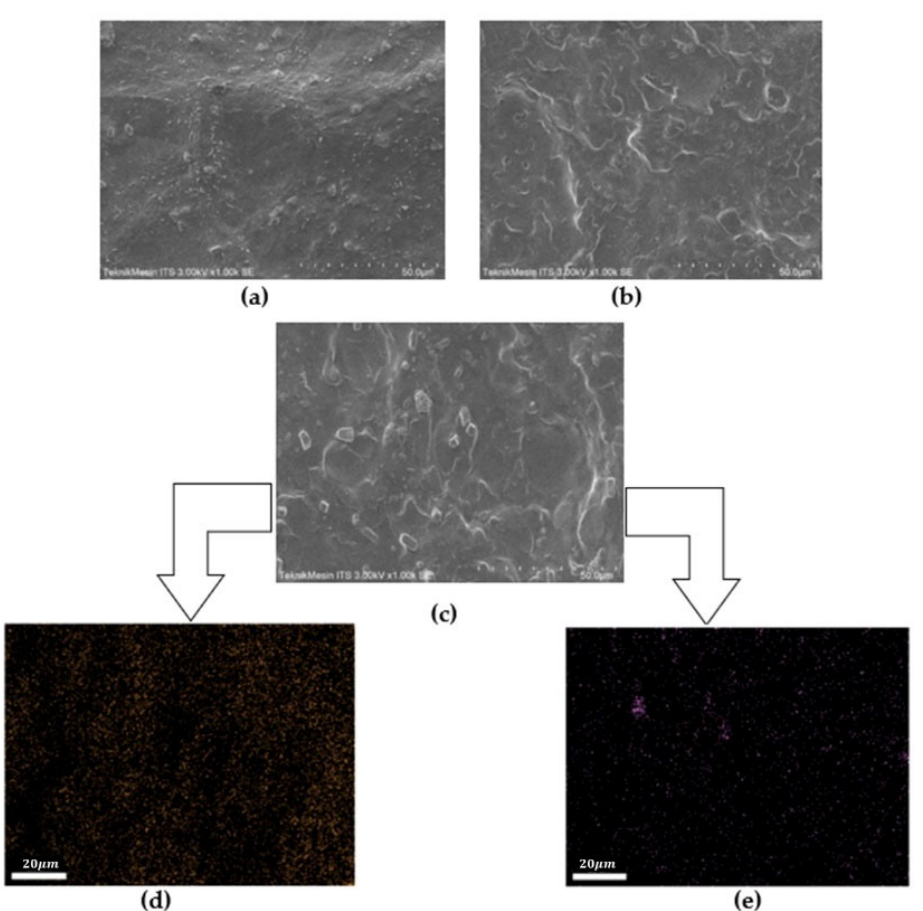
Figure 6. SEM micrograph of: ( a ) pure CS/PEO; ( b ) CS/PEO/NaClO 4 ; ( c ) CS/PEO/NaClO 4 /fly ash;